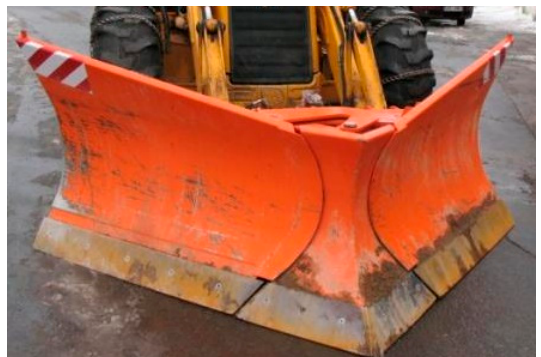
Figure 1. The arrow ploughshare [22].